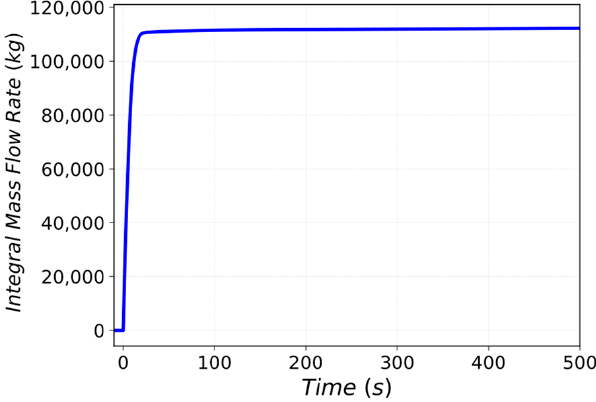
Figure 9. Mass of water discharged into the PHTS area.